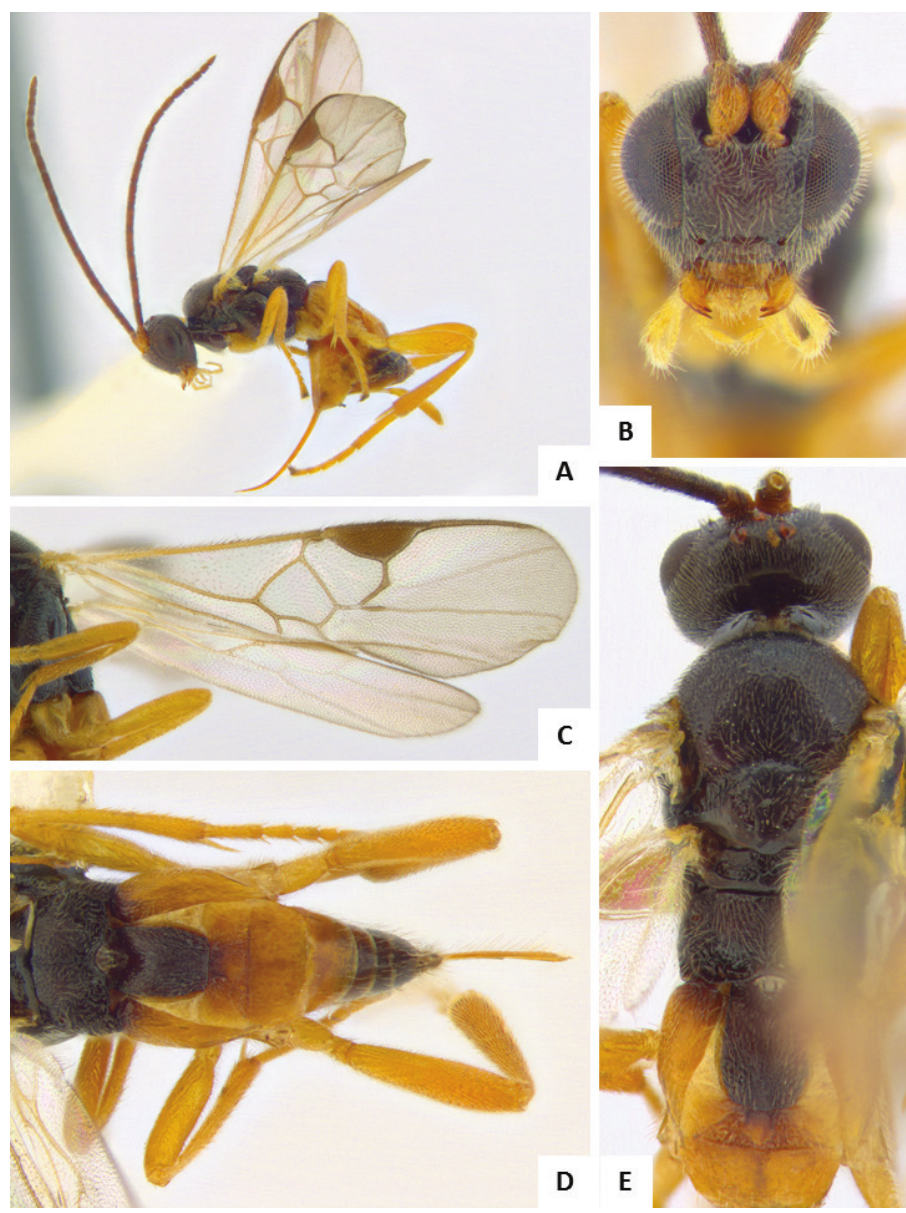
Figure 40. Sathon cinctiformis. A Habitus, lateral B Head, frontal C Wings D Metasoma, dorsal E Head and mesosoma,